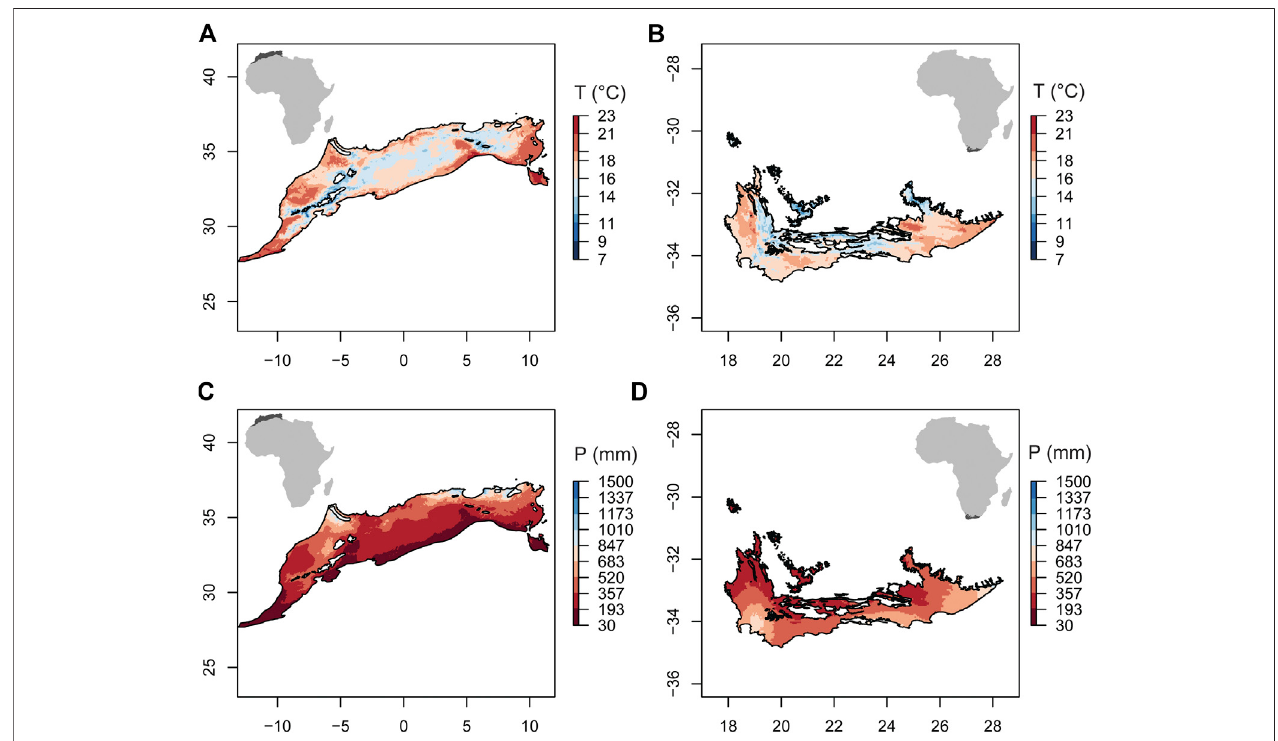
FIGURE1| Annualaveragetemperature(T)andannualprecipitation(P)intheMediterraneanclimateoftheNorthAfrican(NAR)andSouthAfricanregion(SAR). (A) T in NAR; (B) T in SAR. (C) P in NAR; and (D) P in SAR. Data represent an average across 39 years (1980 – 2018) and were obtained from WorldClim v2 (https://www.